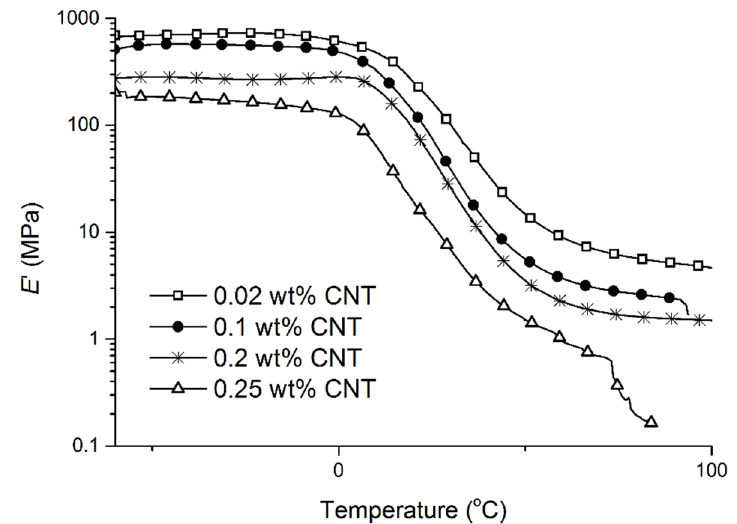
Figure 8. Storage modulus vs. temperature curves of a tung oil-based resin reinforced with different amounts of CNTs and cured under microwaves at 100 W for 10 min, followed by 200 W for 10 min, and a 2 h 10 min post-cure step at 140 °C in a convection